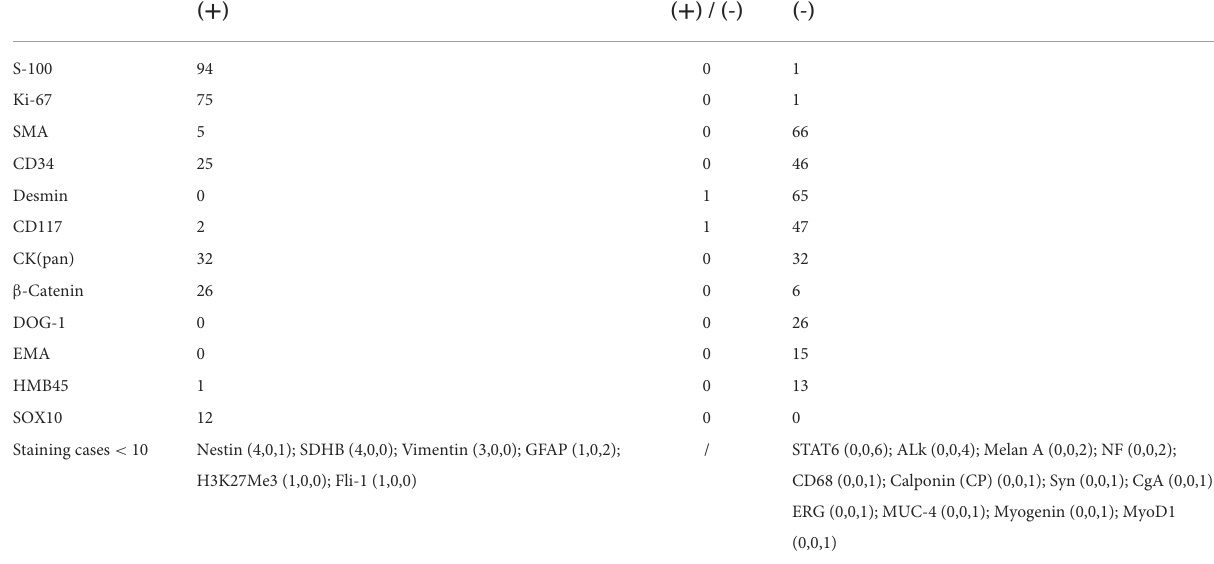
TABLE 3 Number of positive ( + ) and negative (-) staining cases of different immunohistochemical markers.